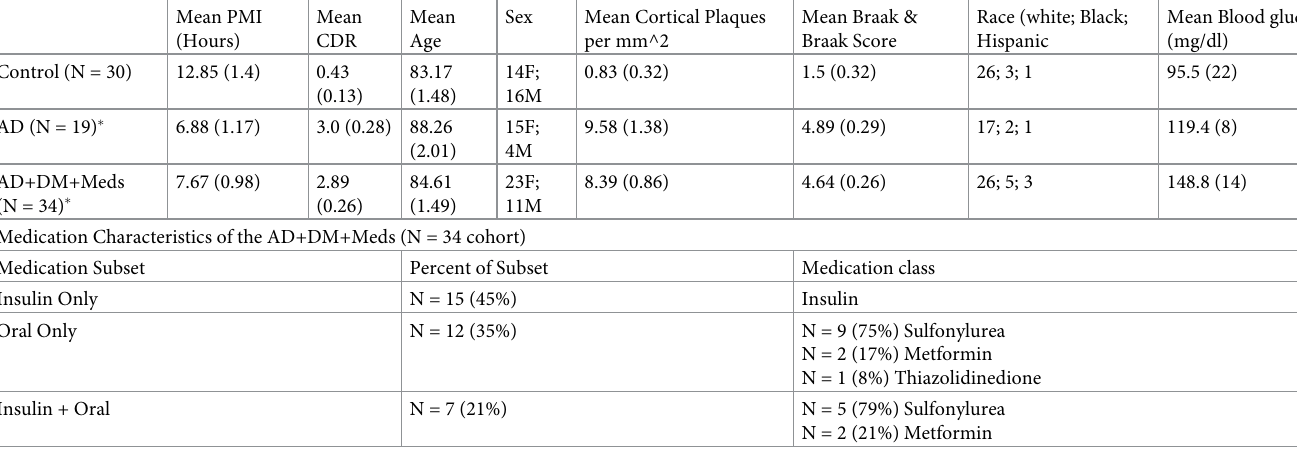
Table 1. Characteristics of the primary study